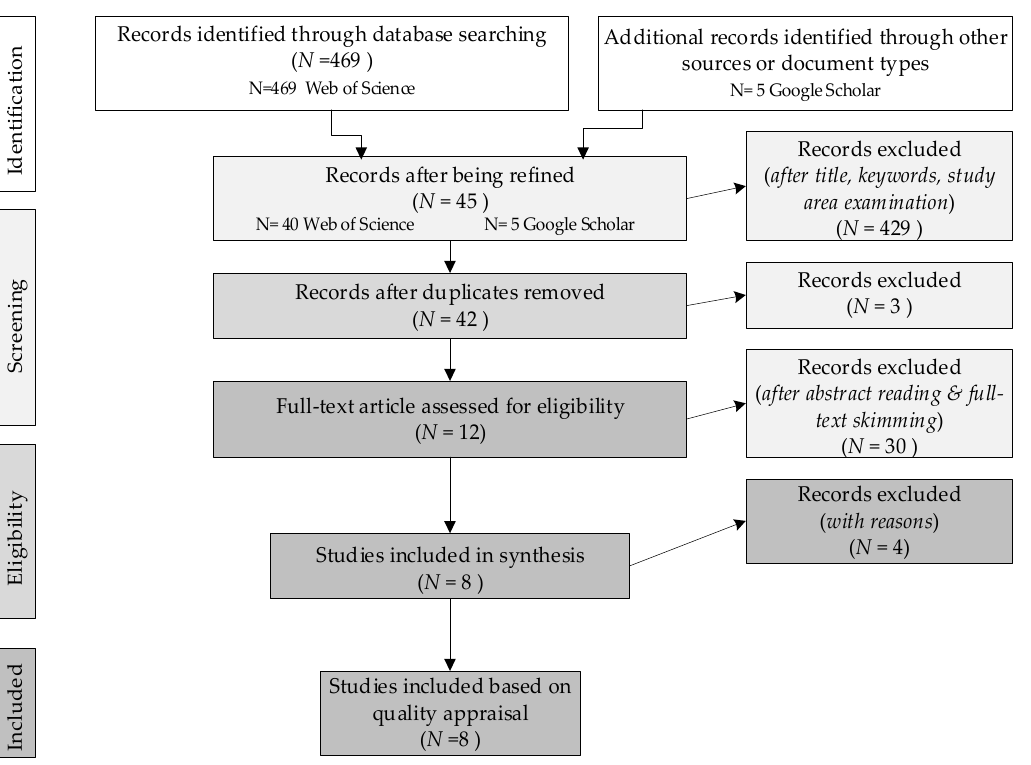
Figure 1. Systematic review based on PRISMA flowchart [29] .